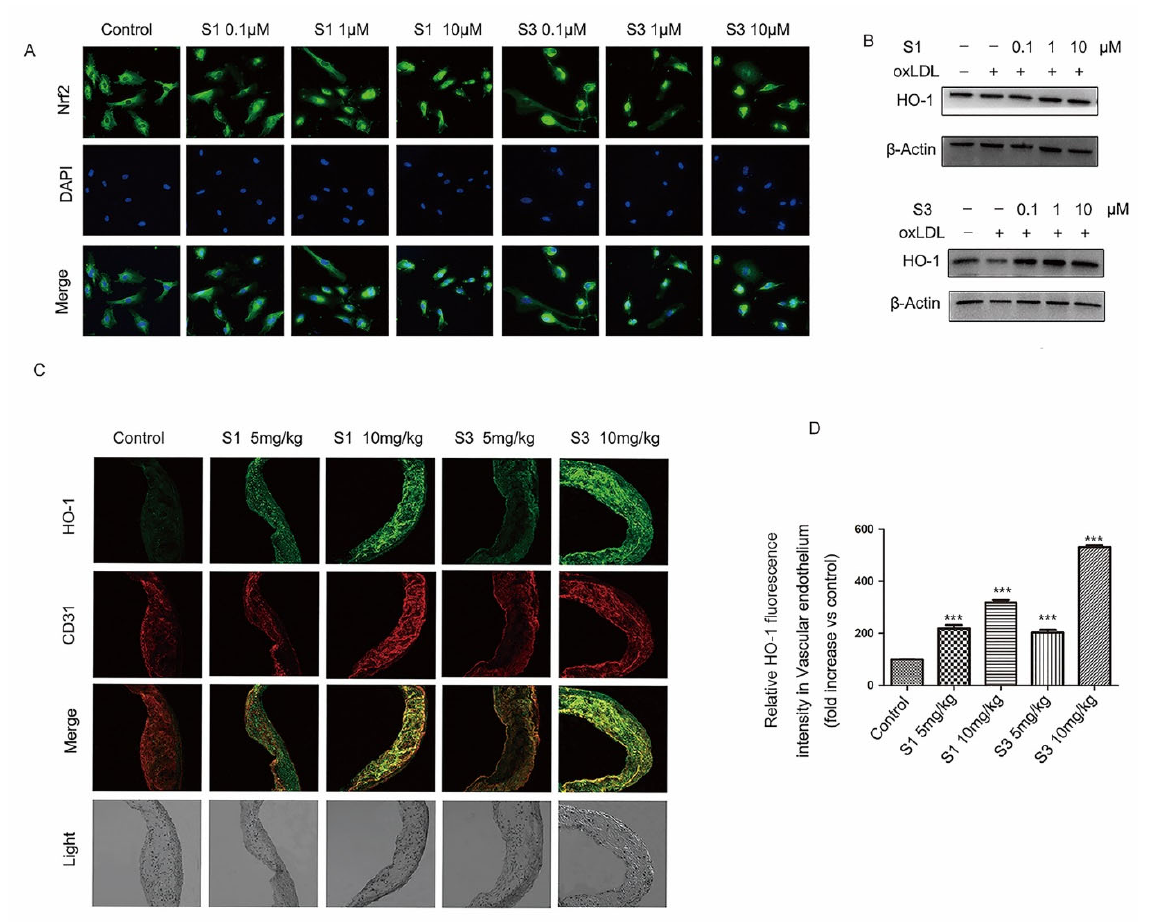
Figure 7. Effect of compounds S1 and S3 on Nrf2 translocation and the target gene HO-1 expression in HUVECs and endothelium of apoE-/- mice. ( A ) HUVECs were incubated with indicated com- pound for 6 h, the Nrf2 distribution in HUVECs were determined by Immunofluorescence staining, n = 3. ( B ) HUVECs were treated with oxLDL (50 μ g/mL), oxLDL and indicated compounds for 6 h. Representative Western blot analysis of HO-1 of 3 independent experiments. ( C ) Double-stained images of colocalization (yellow) of HO-1 with CD31-positive cells in plaque endothelium from apoE-/- mice (200 × ). ( D ) Quantification of HO-1 protein level in endothelium. Data were analyzed by an unpaired two ‐ sided Student’s t ‐ test. *** p < 0.001, vs. control, n = 6 mice per group.